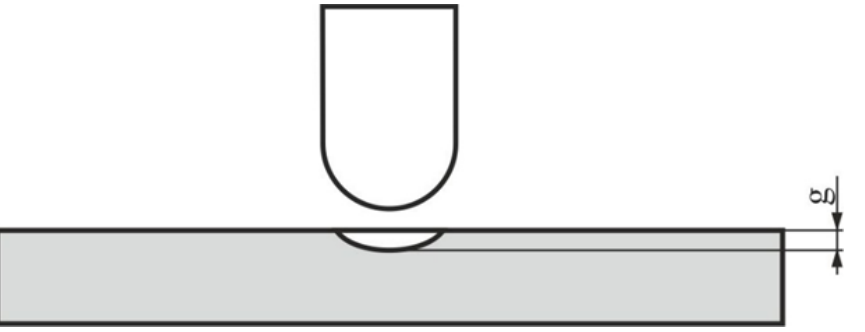
Figure 5. Measured depth of composite damage after concentrated dynamic loading.